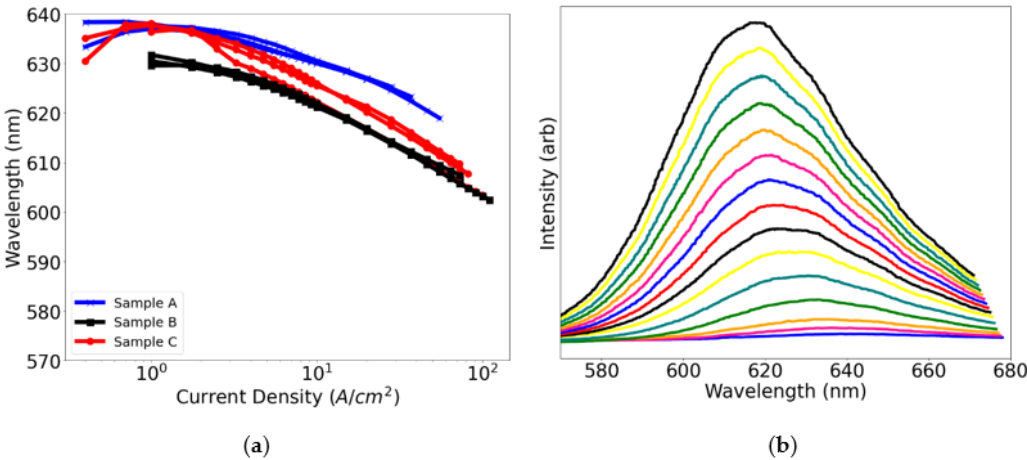
Figure 6. Emission profile of red µLEDs on Si ( a ) Wavelength vs. current density plots for two µLEDs from each sample ( b ) Spectra at various current densities (0.4 – 10 A/cm 2 ) for an 80 µm LED from sample C. Peak emission shifts from 640 nm to 620 nm.